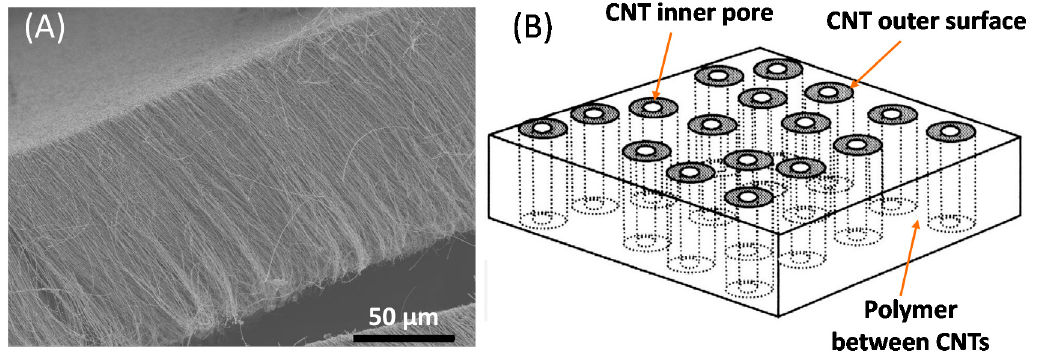
Figure 3. ( A ) Scanning electron microscope (SEM) image of a vertically aligned array of CNTs produced using a Fe-catalysed chemical vapor deposition (CVD) process; ( B ) schematic illustration of the structure of an aligned CNT membrane. From Reference [37]. Reprinted with permission from the American Association for the Advancement of Science.